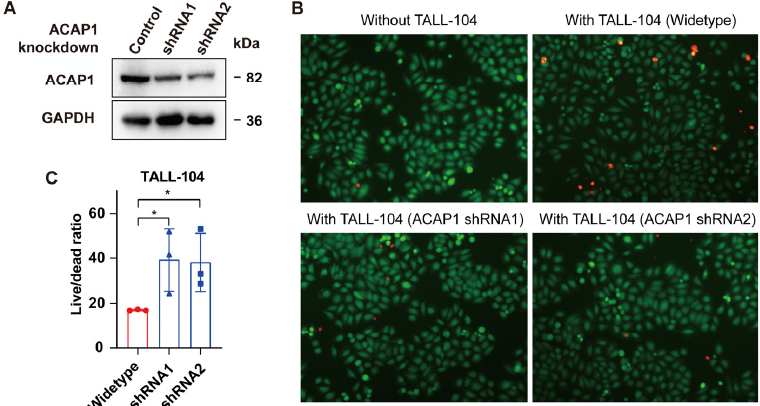
Figure 8. ACAP1 knockdown impairs the cytotoxicity of T cells against tumor cells. ( A ) Western blotting of lysates from TALL-104 cells infected with control or two different ACAP1-targeting shRNA lentiviruses. ( B ) Representative images of live/dead A549 cells co-cultured with different TALL-104 cells at a 1:2 cell ratio for 24 h were shown. Red-fluorescent PI (propidium iodide) was used to detect dead cells. Green-fluorescent CMFDA (5-chloromethylfluorescein diacetate) was used to detect live cells. Scale bars, 100 μ m. ( C ) Three random fields were analyzed, and live/dead cell ratios were quantified. * p <